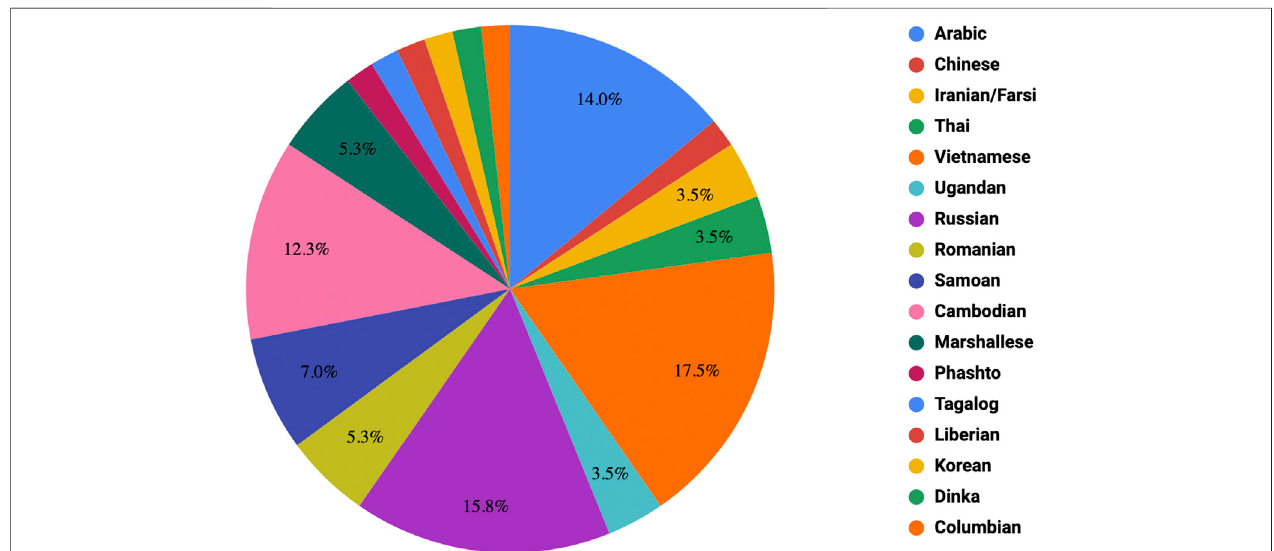
FIGURE 2 | Illustration of non-Spanish student home languages.